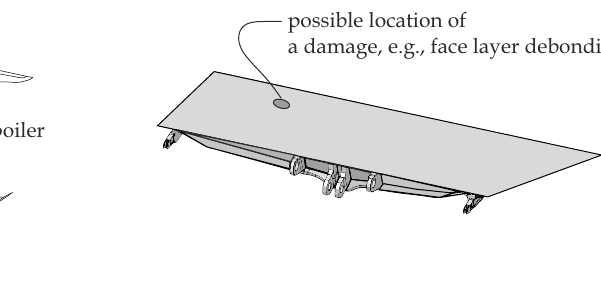
Figure 1. Composite spoiler of a civil